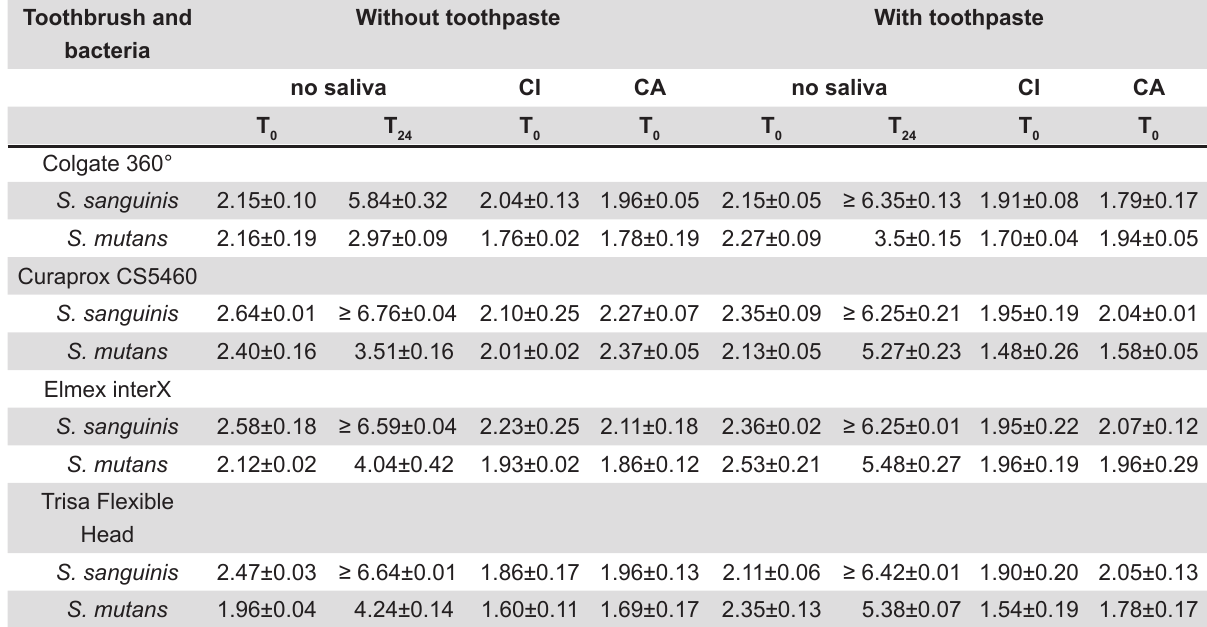
Table 1- Influence of time, toothpaste and saliva on the reduction of streptococcal retention on four different toothbrushes. Either no saliva or saliva collected from a caries-inactive (CI) or a caries-active (CA) volunteer was used, and the artificially contaminated toothbrushes were analyzed after either three minutes (T counts are shown as the mean-log10 factors and standard deviations. Two independent experiments (n=2) were performed for each set of parameters. A higher number indicates a greater bacterial reduction, and "≥" denotes reductions to levels below the respective detection